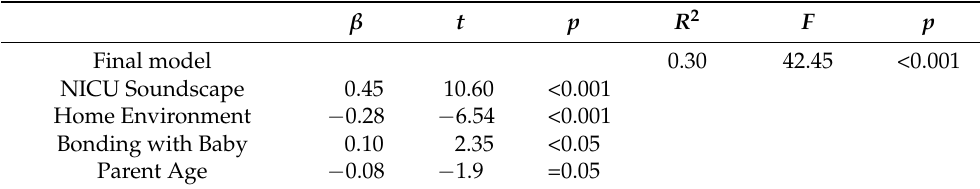
Table 7. Final regression model predicting the PPQ-Total Score after progressively removing “Singing- Recordings”, “Parenting Confidence” and “Infant